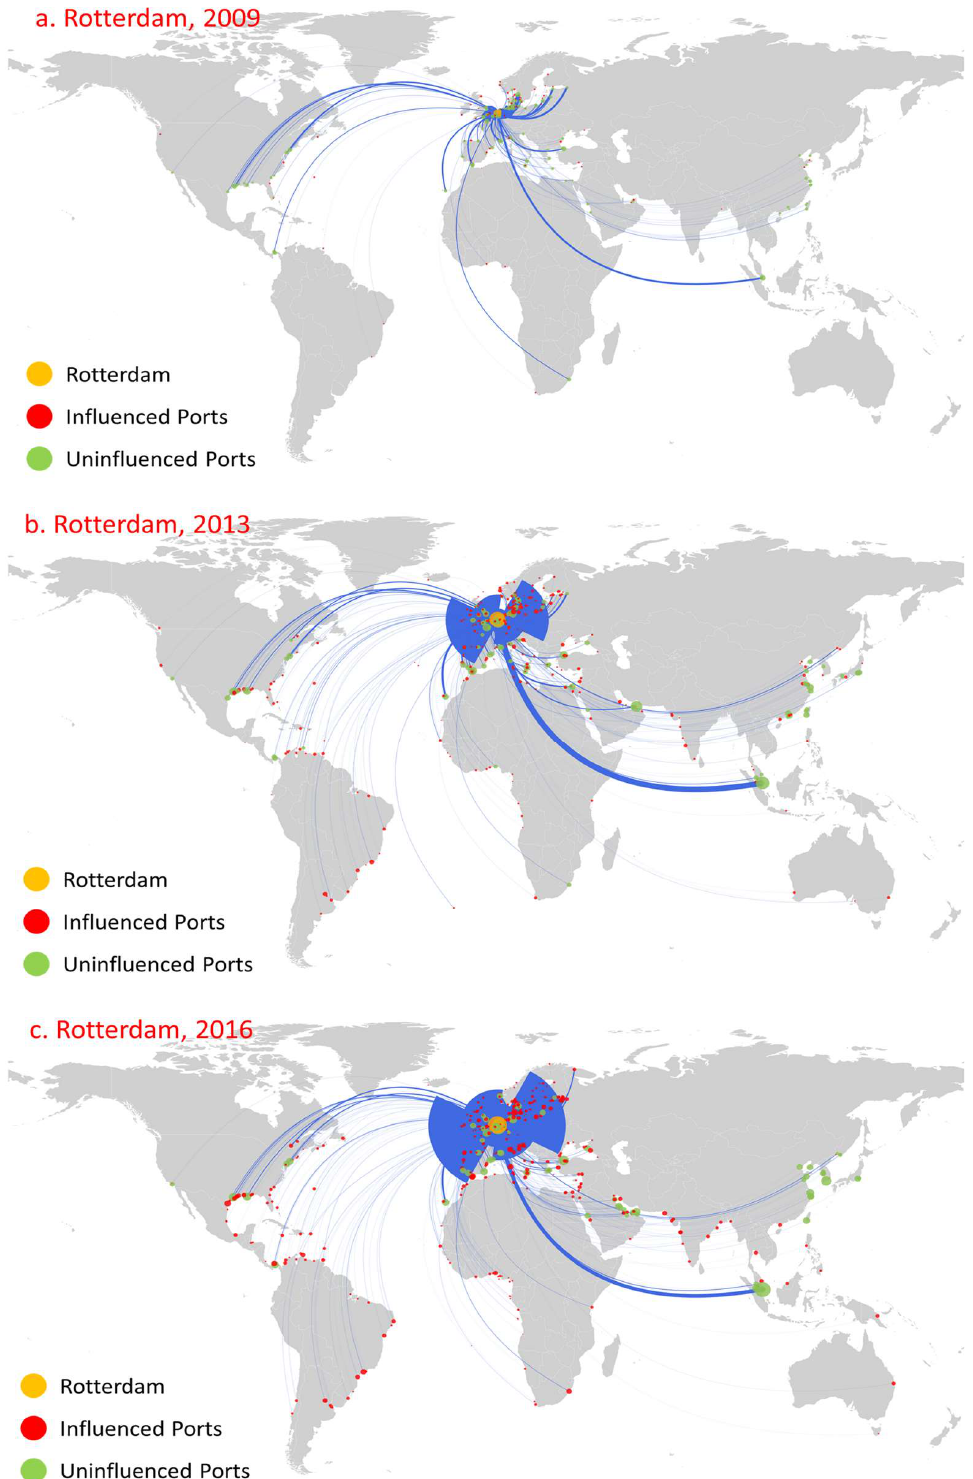
Figure 4. Influence diffusion at the first stage: Rotterdam. Note: the orange node denotes the initial diffusion port, while the blue line denotes the trade route from the initial diffusion port to the destination ports worldwide. The red node denotes the influenced node at the first stage, namely the directly influenced ports, while the green node denotes the uninfluenced node. (The same for the following Figures 5, 6 and